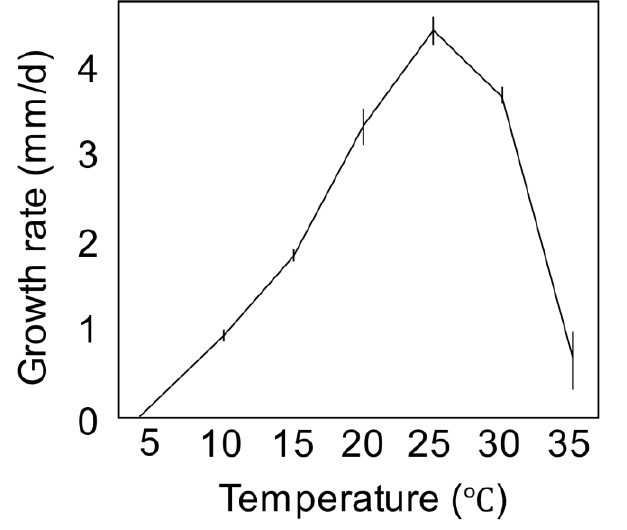
Figure 4. Mycelial growth rate of F. mindanaoense PD20-05 on PDA depending on the temperature in the dark for 6 days.